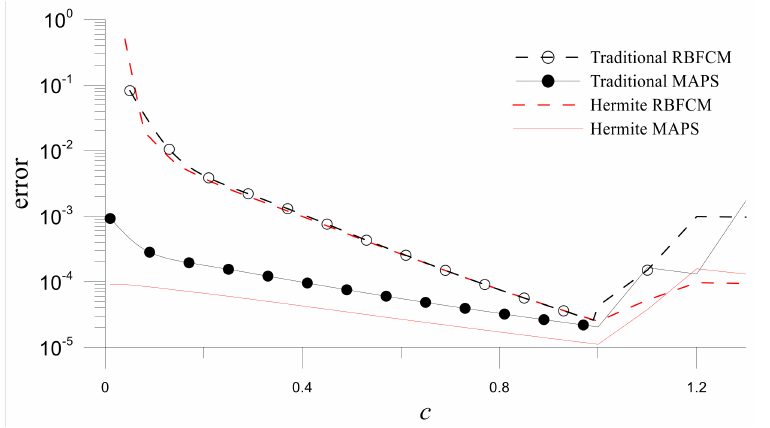
Figure 16. Errors of numerical solutions obtained by the four methods with different values of c at t = 4 for Example